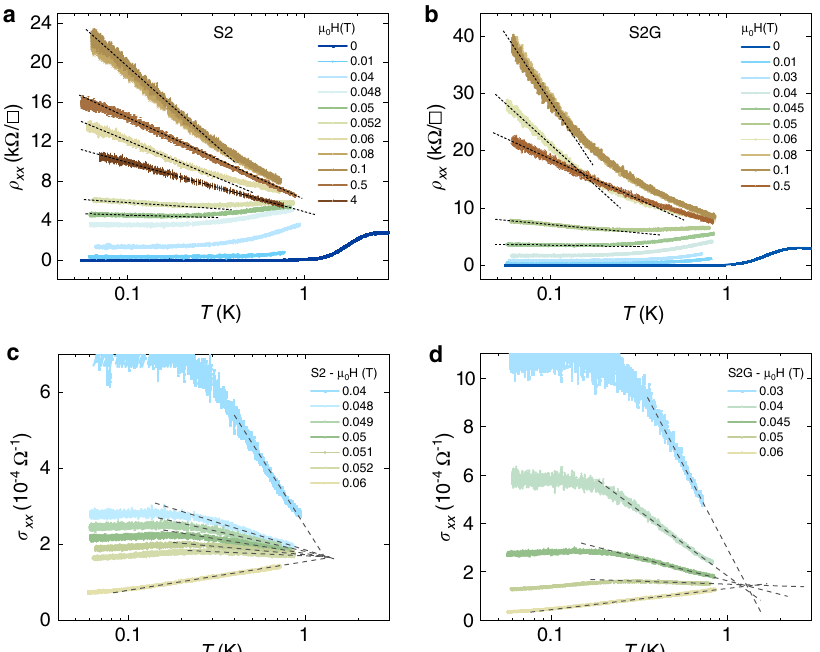
Fig. 3 Logarithmic divergence of resistivity and conductivity proximate to the avoided H-SIT. a , b Resistivity versus logarithm of temperature in perpendicular magnetic fi eld, for anneal stage S2 and S2G, respectively. Note the difference in resistivity scales. Dotted lines are guidance to the eye, demonstrating the logarithmic divergence of resistivity over a broad temperature range. c , d Conductivity versus logarithm of temperature for S2 and S2G, obtained by inverting the data in ( a ) and ( b ). Logarithm divergence of conductivity is found before the saturation sets in at low